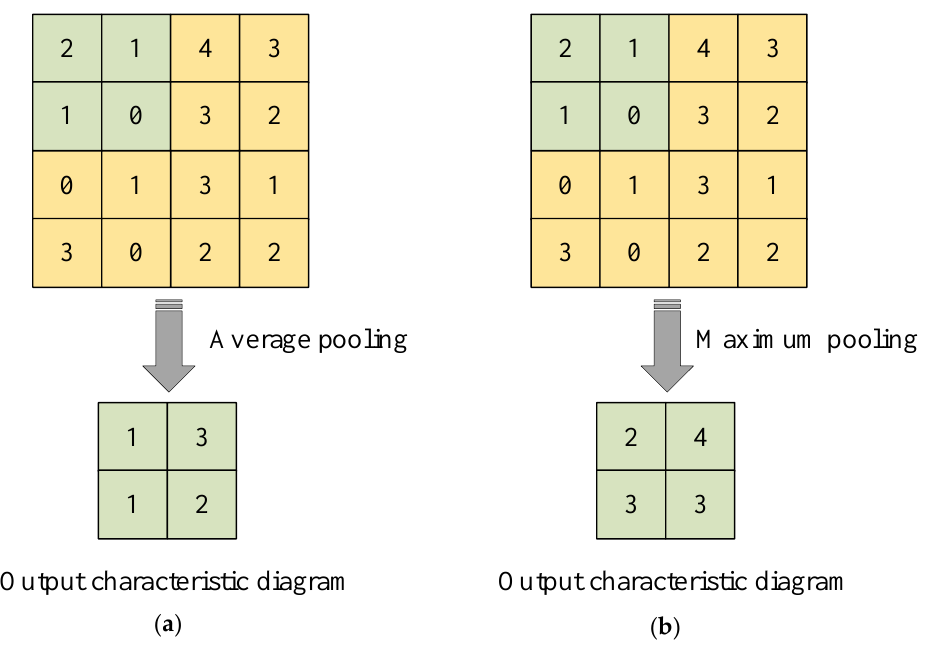
Figure 3. The diagram of the two pooling operations: ( a ) average pooling; ( b ) maximum pooling.